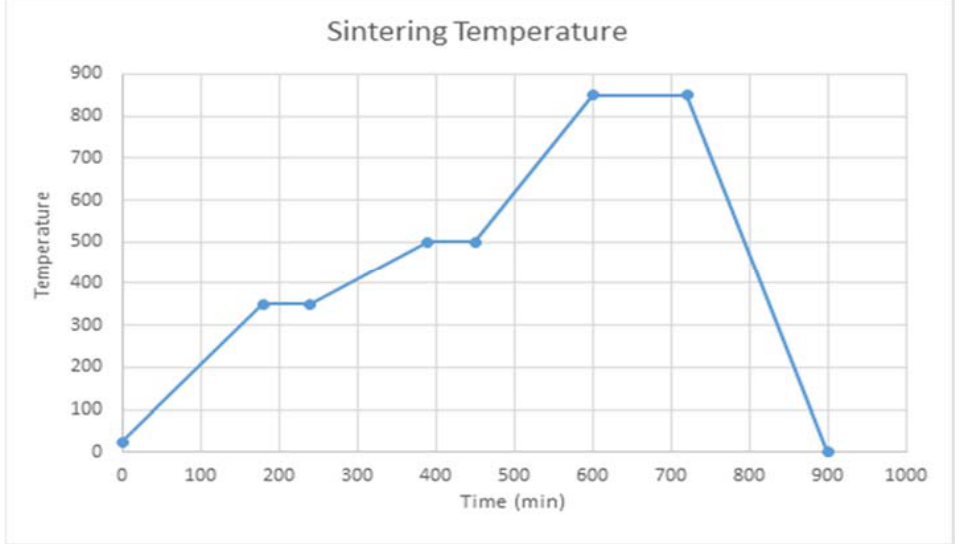
Figure 7. Three ‐ stage sintering process.